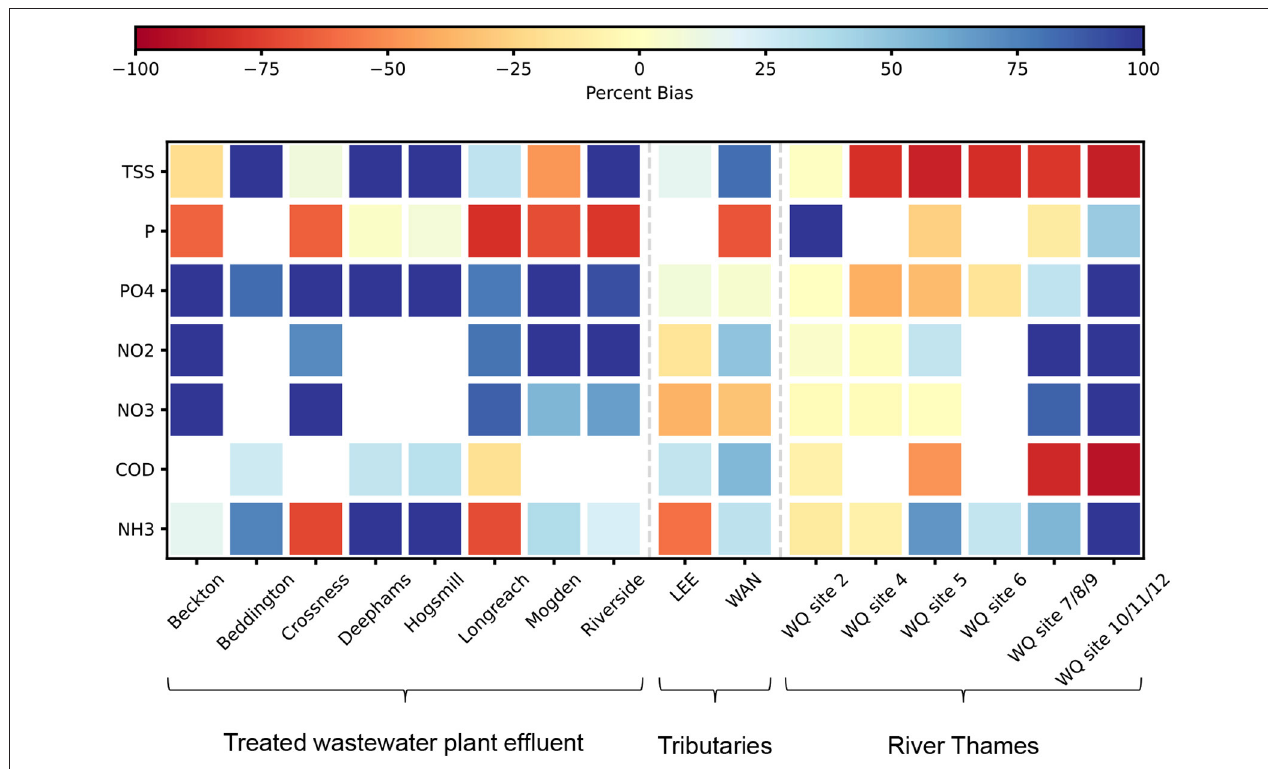
FIGURE 6 | Percentage bias metric between simulated and sampled water quality values for treated effluent arcs (left side), in-river arcs for tributaries to the River Thames (central) and in-river arcs for the River Thames (right side). Cells that have been left blank have no recorded water quality samples. Values with a percent bias greater than ± 100% have been set to 100 to improve the visual interpretation of the plot. Locations for arcs can be matched to Figures 1 , 4 .